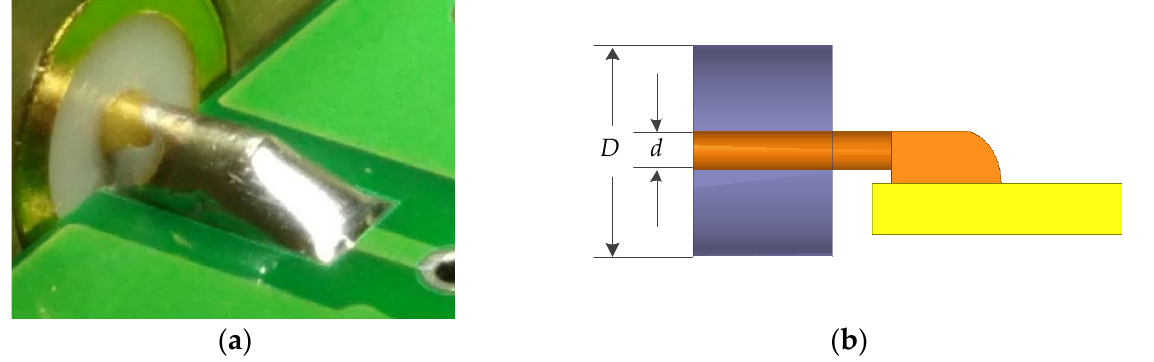
Figure 1. Directly soldered structure. ( a ) Photo of the directly soldered structure; ( b ) Model of the directly soldered structure.